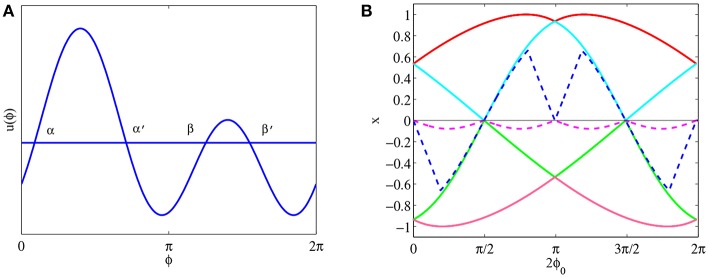
(A) A sketch of u(θ) = B cos ϕ + C cos 2(ϕ − ϕ0), 0 < B < C. (B) Four solid lines represent the four roots of Equation (49), i.e., cos α, cos α′, cos β and cos β′, while two dash lines represent all possibilities of cos − cos α′ + cos β − cos β′. Parameter k = 0.8.